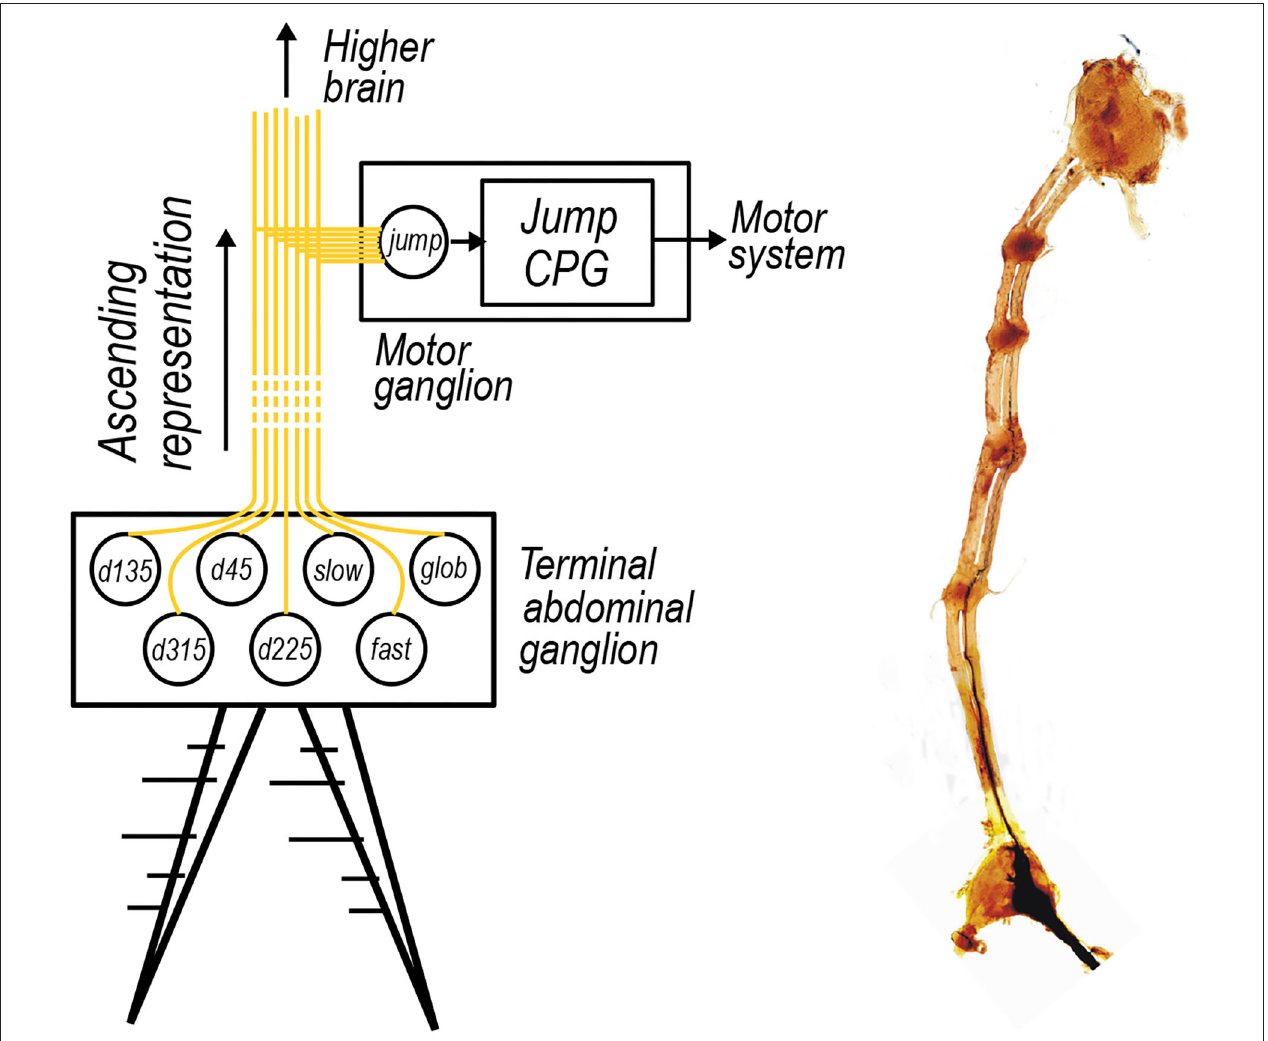
FIGURE 5 | (A) The activations of the seven interneurons included in the cercal escape system model ascending up the nerve cord to a higher ganglia. Such a higher ganglion is proposed to contain a neuron or group of neurons, here labeled jump, that looks for certain patterns of activation in the seven interneurons to activate a jump central pattern generator, labeled as jump CPG, to initiate an escape motor routine. (B) An optical microscopy image of the ganglion chain of the wood cricket, stained using a cobalt chloride dye. The terminal abdominal ganglion sits at the base of this chain which ascends up to the central brain contained within the head of the animal. Intermediate ganglion, which for example control one of the insects motor systems, appear as more densely stained red dots along the